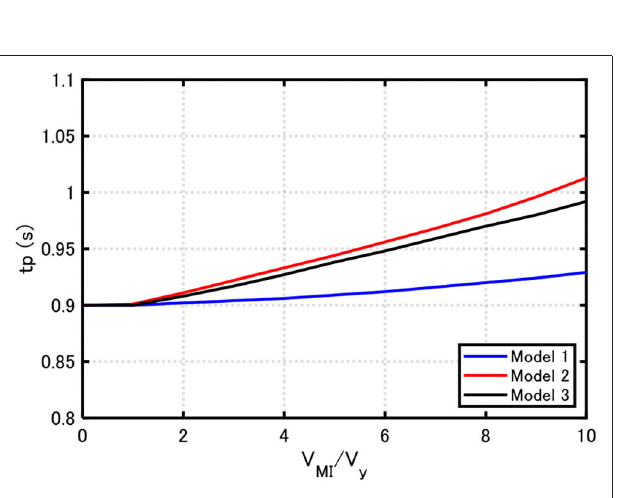
FIGURE 10 | Critical input interval t p vs. input velocity